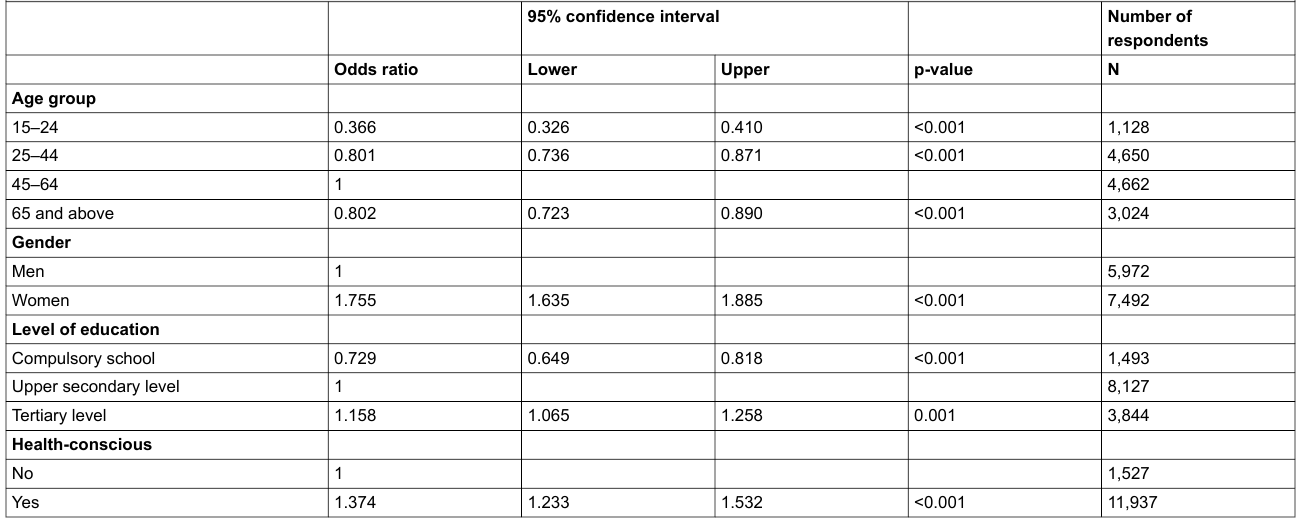
Table 5: Logistic regression model: Holding an additional health insurance for CM (Swiss Health Survey, Switzerland, 2007). 95% confidence interval Number of